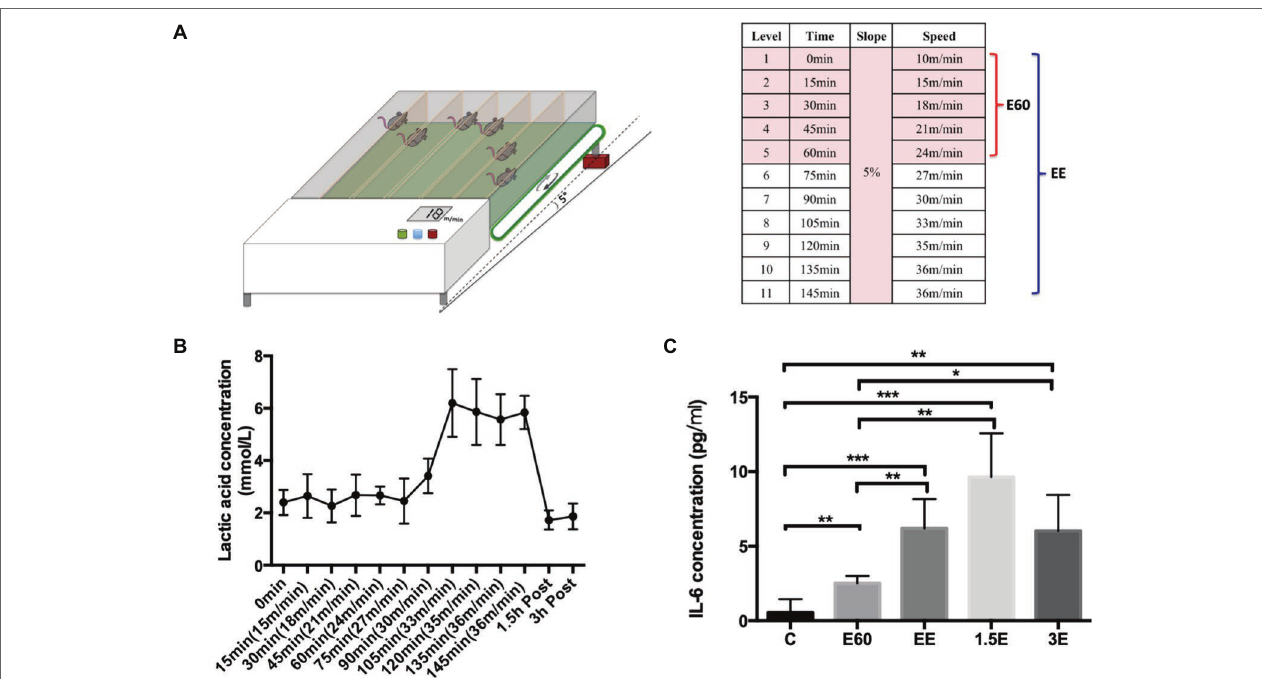
FIGURE 1 | Exhausted treadmill running protocol, LA and IL-6 expression levels. (A) The mouse treadmill used in this study was equipped with six separate lanes and the capacity to change the running speed and slope. After a 15-min warmup, the running speed was increased 3 m/min every 15 min with the slope set at 5%. Group E60 finished the first six levels while group EE finished all 11 levels. (B) The blood lactic acid concentration was determined by the EFK Lactate Scout using blood drops obtained from the mouse tail after each speed level and after 1.5 and 3 h recovery. Data are expressed as the mean ± SEM. (C) Plasma IL-6 concentrations were tested by Quantikine ELISA kit. Data are expressed as the mean ±